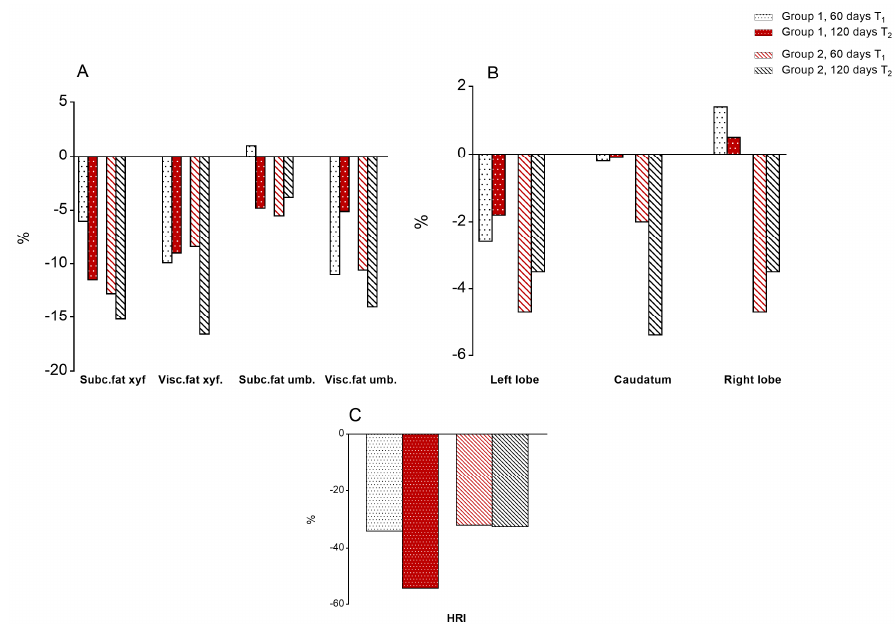
Figure 3. Percentage changes in ultrasound parameters at 60 and 120 days compared to baseline. Statistically significant di ff erences are reported in Table S6. ( A ) Body fat; ( B ) Liver size; ( C ) Hepato-Renal Index, HRI. White = RCR, Red = RCR + T.